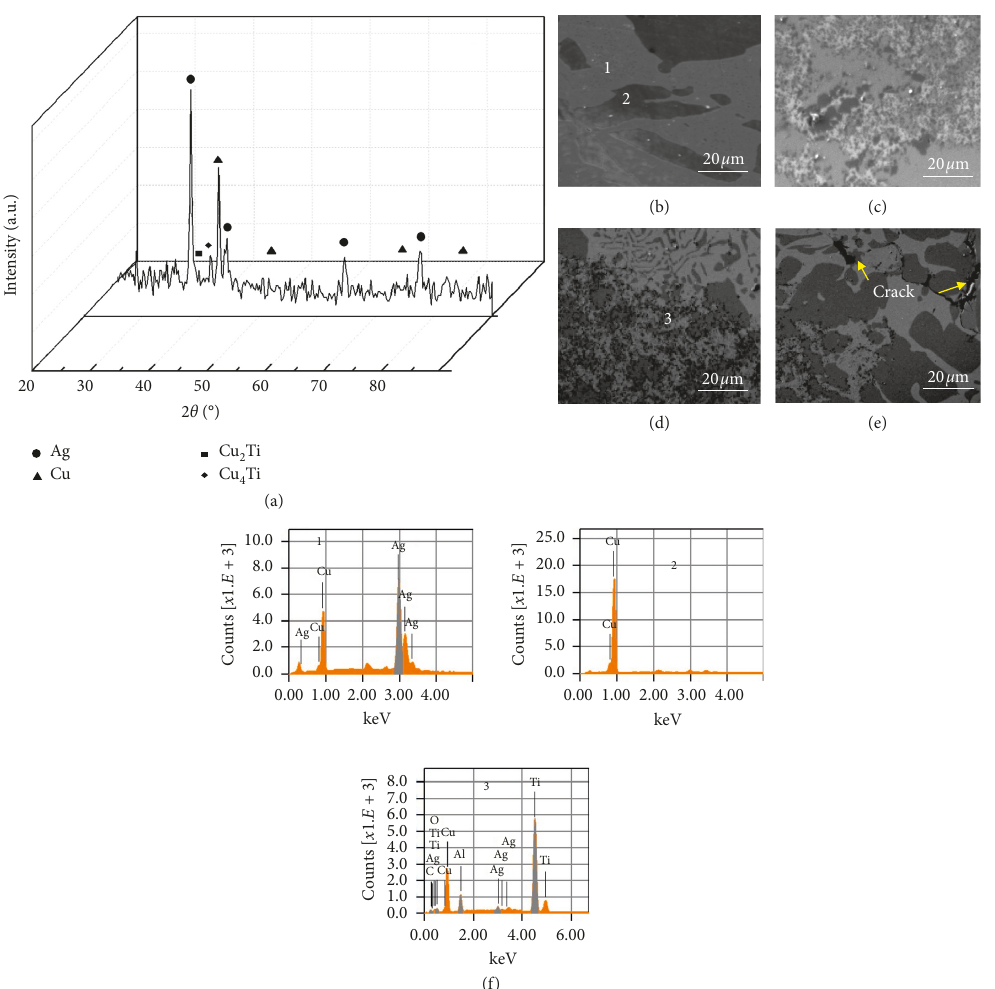
� 0, 0.03, 0.05, and 2 filler, x